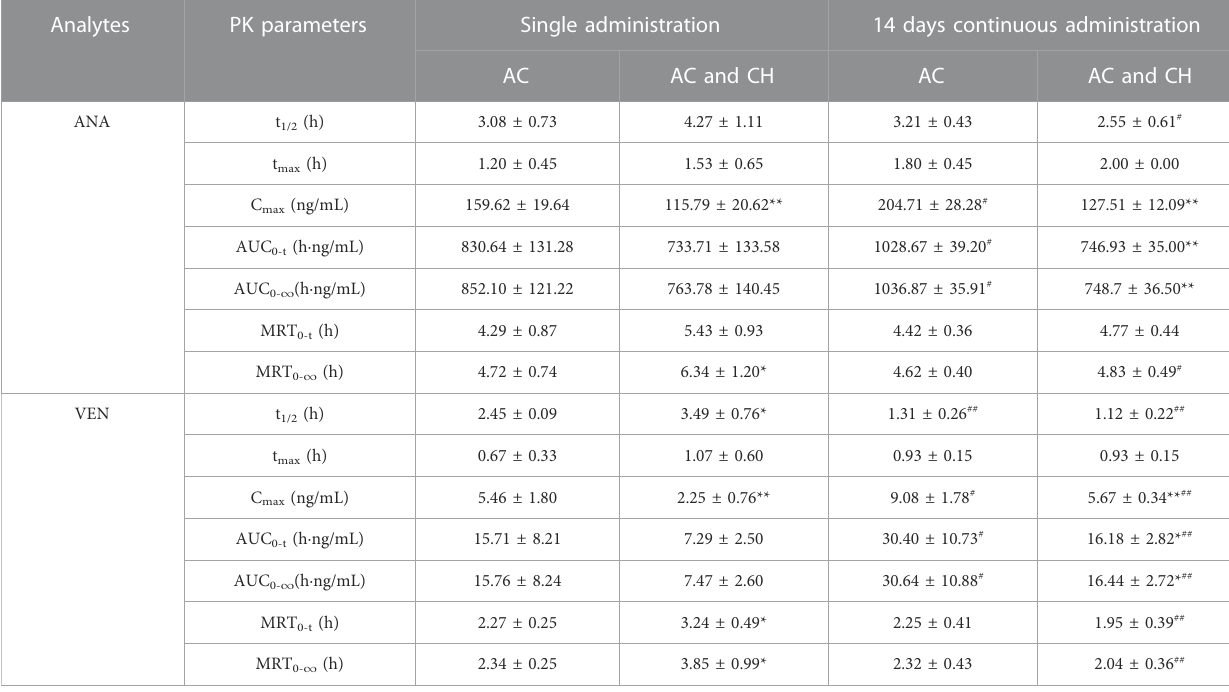
TABLE 5 The pharmacokinetic parameters of anabasine (ANA) and venoterpin (VEN).